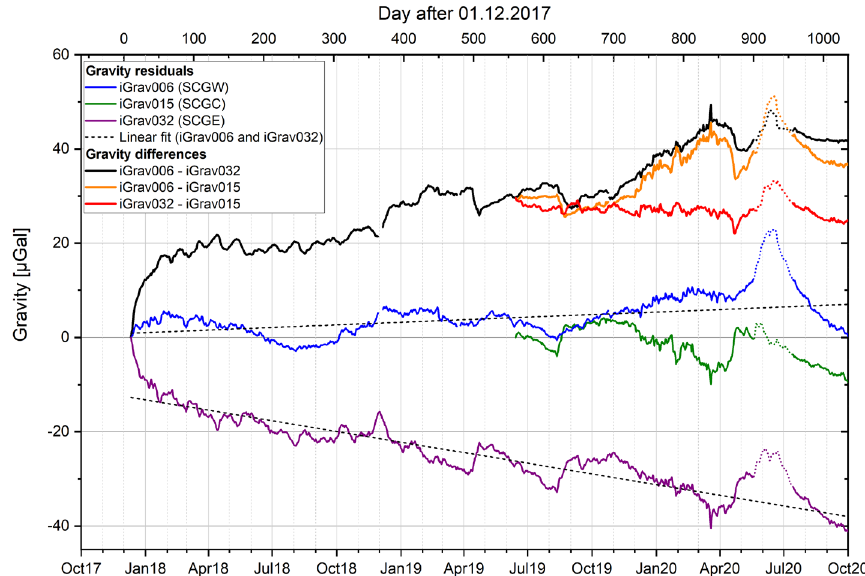
Fig. 6 Gravity residuals and differences between iGrav006, iGrav015 and iGrav032 after reduction of global effects, soil water content variations and vertical surface displacement; dotted sections of gravity residuals show possible effects of snow melting between May and July 2020, which are excluded for the linear approximations for iGrav006 and iGrav032 (black, dashed